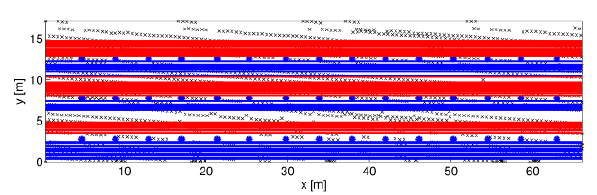
Figure 9. Horizontal edges for all window outlines shown in Figure 7, lower edges are painted in blue, upper edges in red.